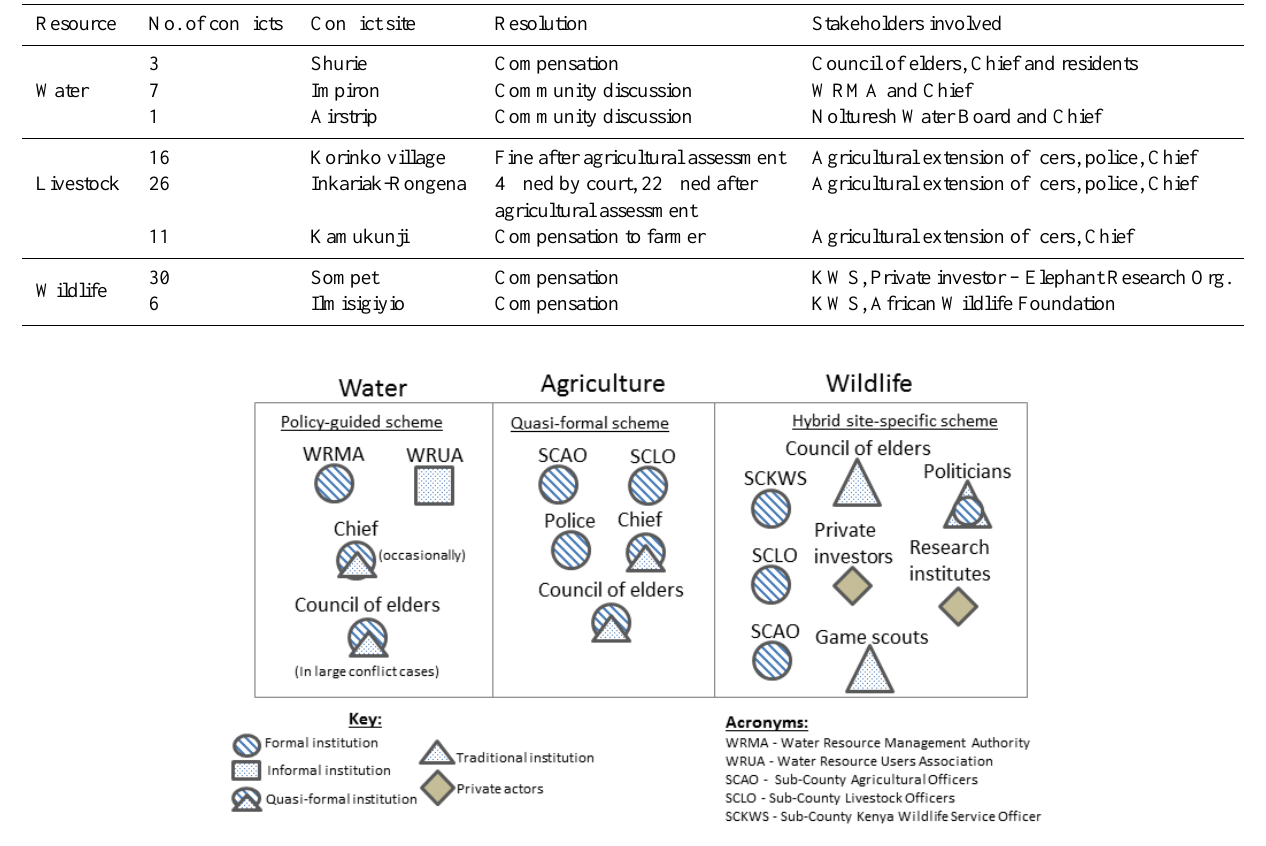
Figure 2. The diverse resource conflict resolution schemes in Loitoktok